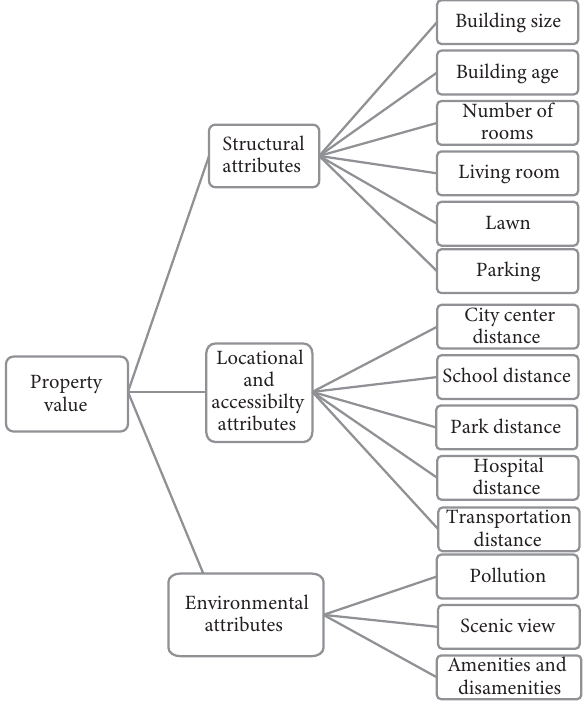
Figure 1. Conceptual